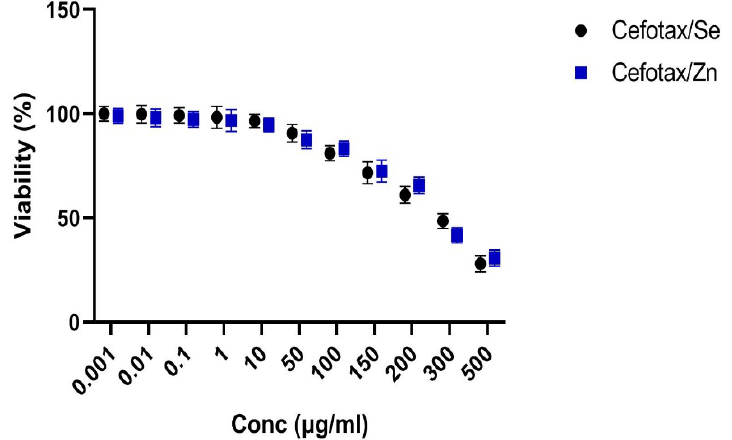
Figure 10. SRB (quick screening) curve of cefotax/Se and cefotax/Zn against HepG2 cells.